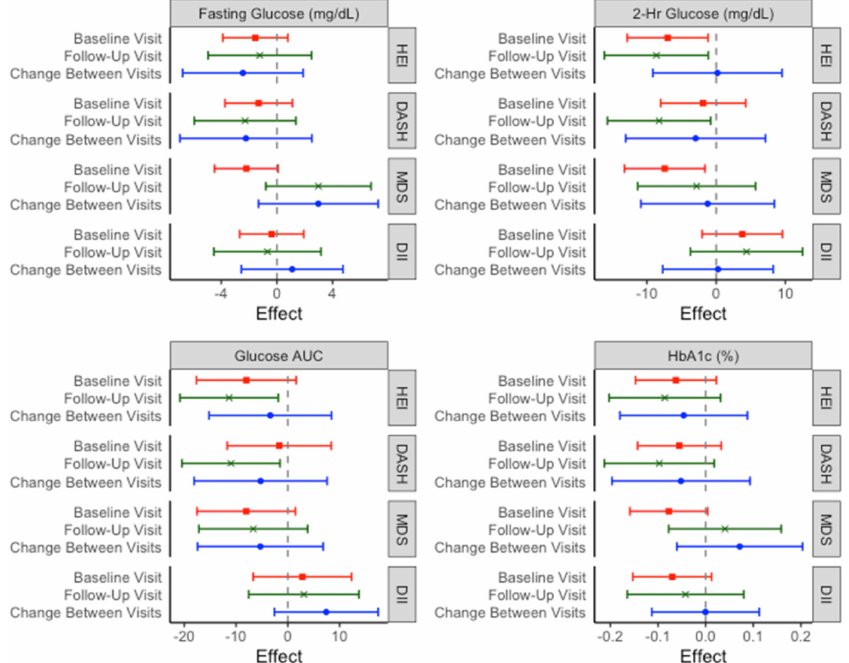
Figure 2. Coefficient plots for the effects of diet quality on glucose measurements. “Baseline” and “follow-up” values are the result of cross-sectional analyses of diet quality score and each outcome. The value for “change between visits” represents the association between the change in diet score between the baseline and the follow-up visit on the change in outcome between visits. Effects are scaled to one standard deviation of exposure. Covariates: Baseline and follow - up models: HEI, DASH, and DII models adjusted for age, sex, ethnicity, physical activity, and parental education. MDS models adjusted for energy intake, age, ethnicity, physical activity, and parental education. Change between visits models: Baseline and follow-up model covariates + baseline diet score. Abbreviations: DASH: Dietary Approaches to Stop Hypertension; DII: Dietary Inflammatory Index; HEI: Healthy